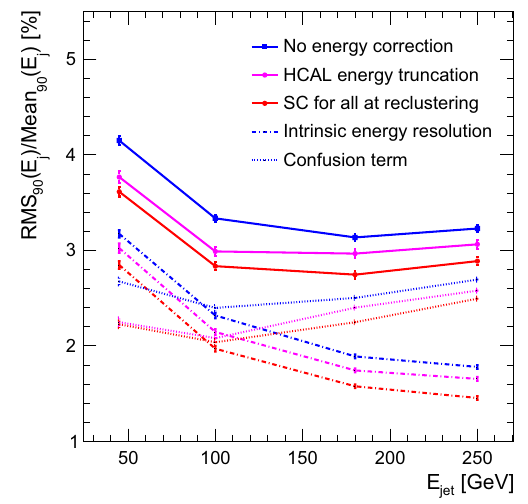
Fig. 9 Jet energy resolution for ILD detector with standard HCAL cell size without energy correction (blue), when applying HCAL cell trun- cation combined with a downscaling of clusters with very high energy density (magenta) and when applying SC at reclustering step for all clusters (red). The long-dashed lines present the performance obtained with perfect pattern recognition, whereas the dotted lines present the confusion term, defined as the quadrature difference between the real jet energy resolution and the one obtained with perfect pattern recogni-